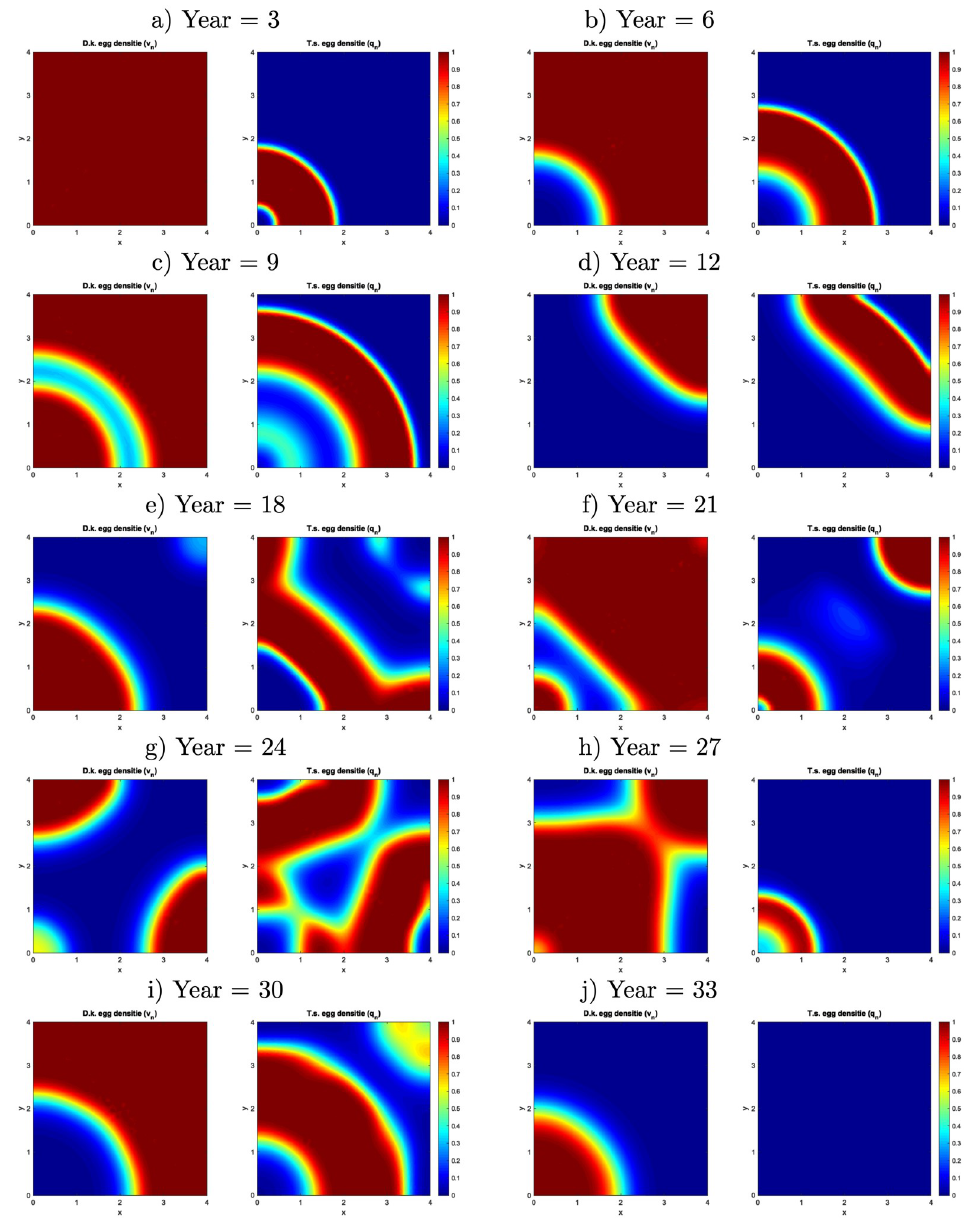
Fig 5. Spatial evolution of the D . kuriphilus and T . sinensis egg density over the years, in an area of 4 × 4 non- dimensional length units.